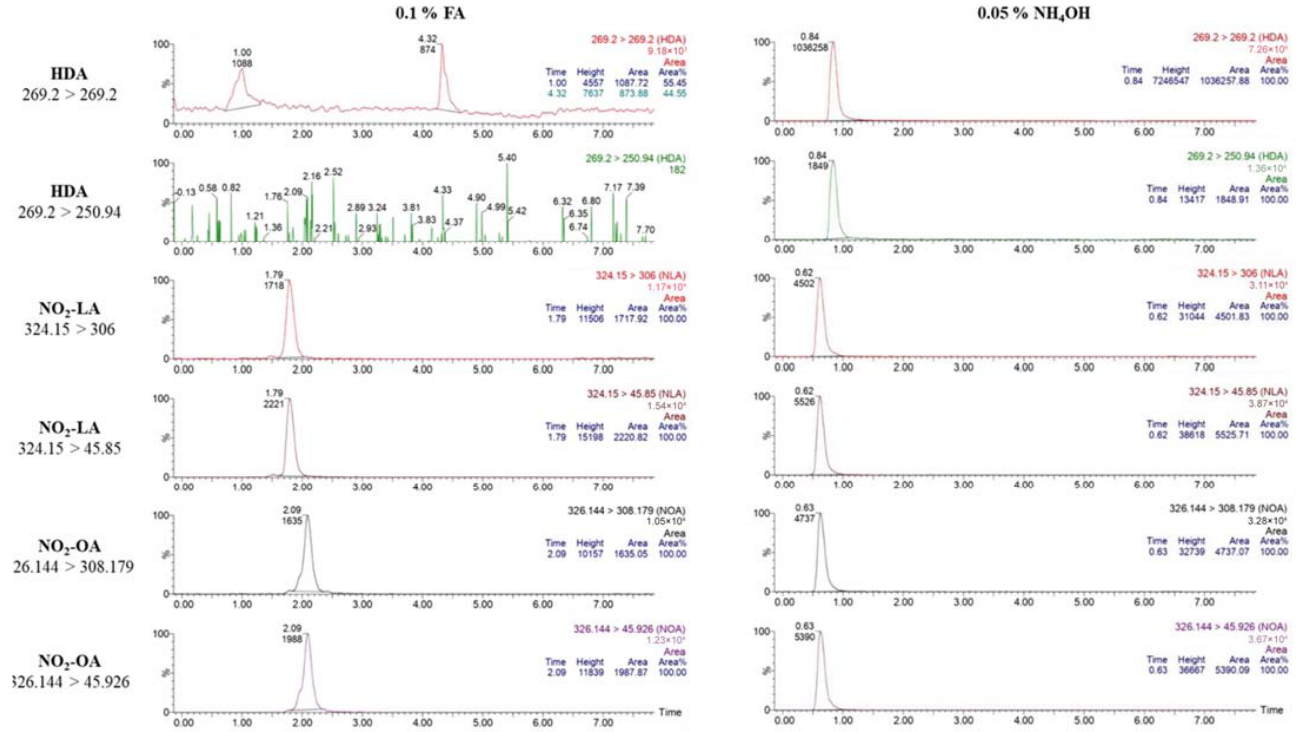
Figure 5. Retention and sensitivity of NO 2 -OA, NO 2 -LA and HDA on reversed phase UPLC-MS/MS using acidic ( right ) and basic ( left ) mobile phase additives.